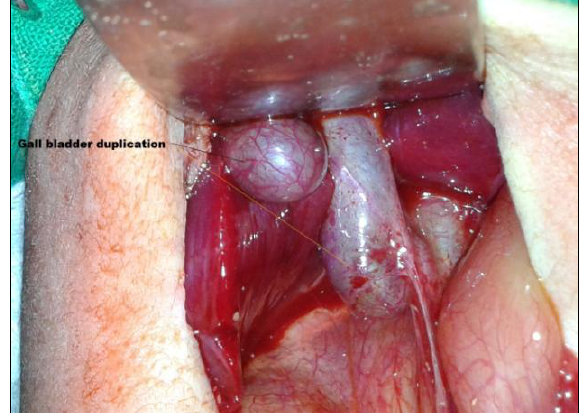
Figure 1: Intra-operative picture showing duplication of